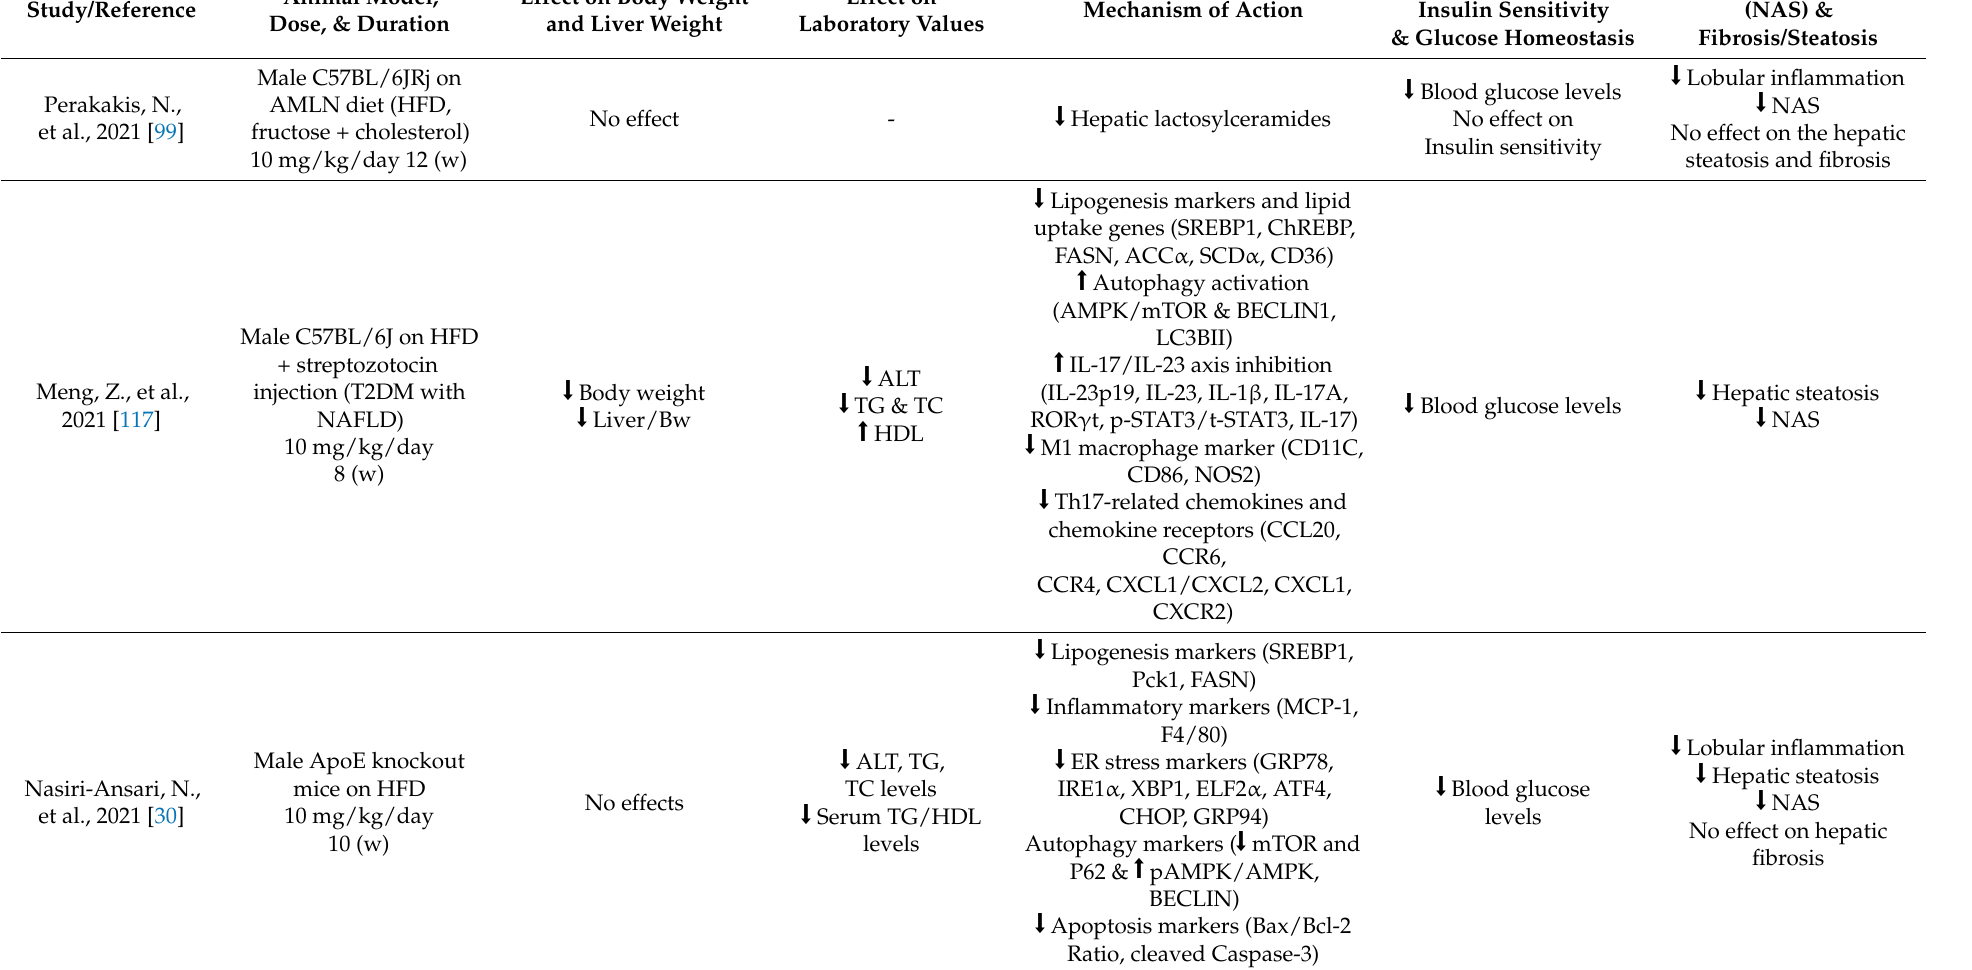
Table 1. Key animal studies regarding the impact of empagliflozin on NAFLD/NASH.